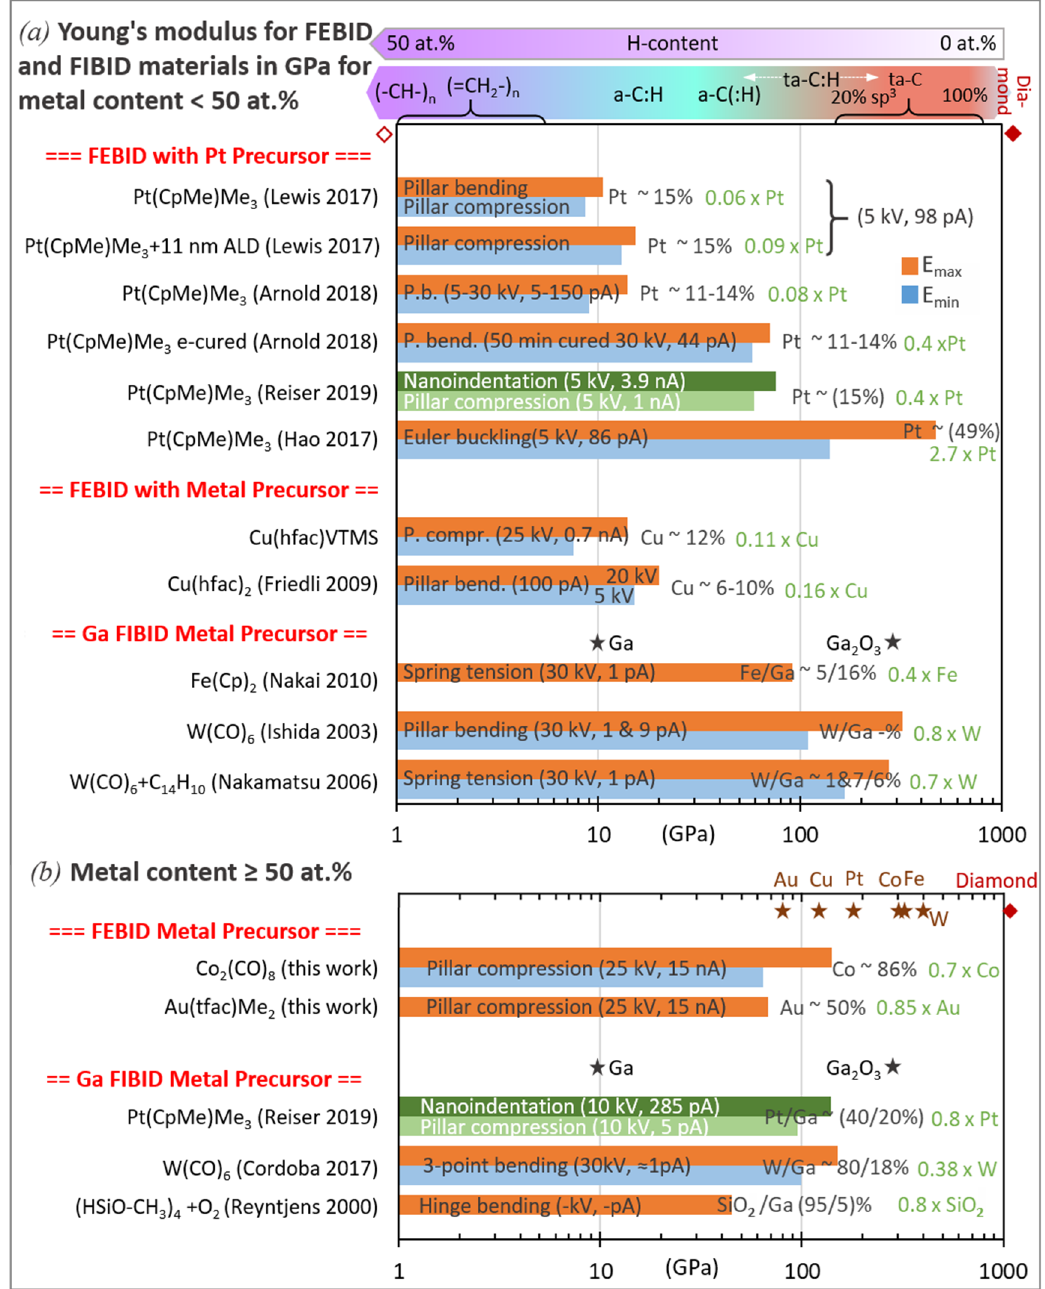
Figure 16. Summary of elastic moduli measurements of FEBID and FIBID-grown metal–carbon materials. The vertical axis lists the precursor molecule employed to grow the structure together with the first author. Bulk elastic moduli for metals, gallium, gallium oxide, and diamond are shown for orientation. The data point entries give the corresponding elastic modulus ratios of deposit to bulk metal. Metal contents are in at.% (parenthesized values were inferred from separate literature). The measurement methods and deposition conditions (acceleration voltage, beam current) are shown inside the bars. Maximum and minimum values have specific legends when parameter studies were performed; otherwise, they show the experimental scatter. Green shades signify measurements on uniform material that has no potential core–shell structure hidden. (a) Deposits with metal content below percolation threshold and (b) deposit material with metal content > 50 at.% and percolation threshold. Note the logarithmic horizontal